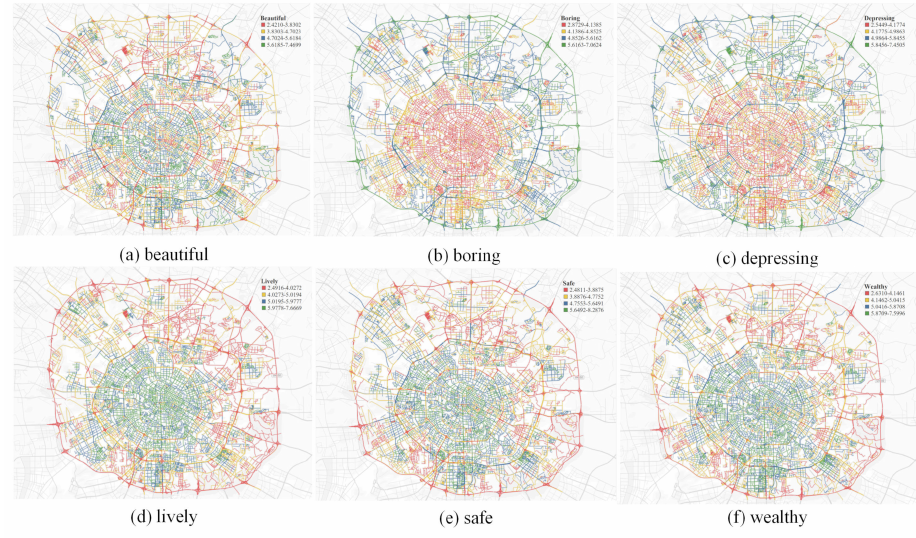
Figure 7. Spatial distribution of the human perceptions with six perceptual attributes in